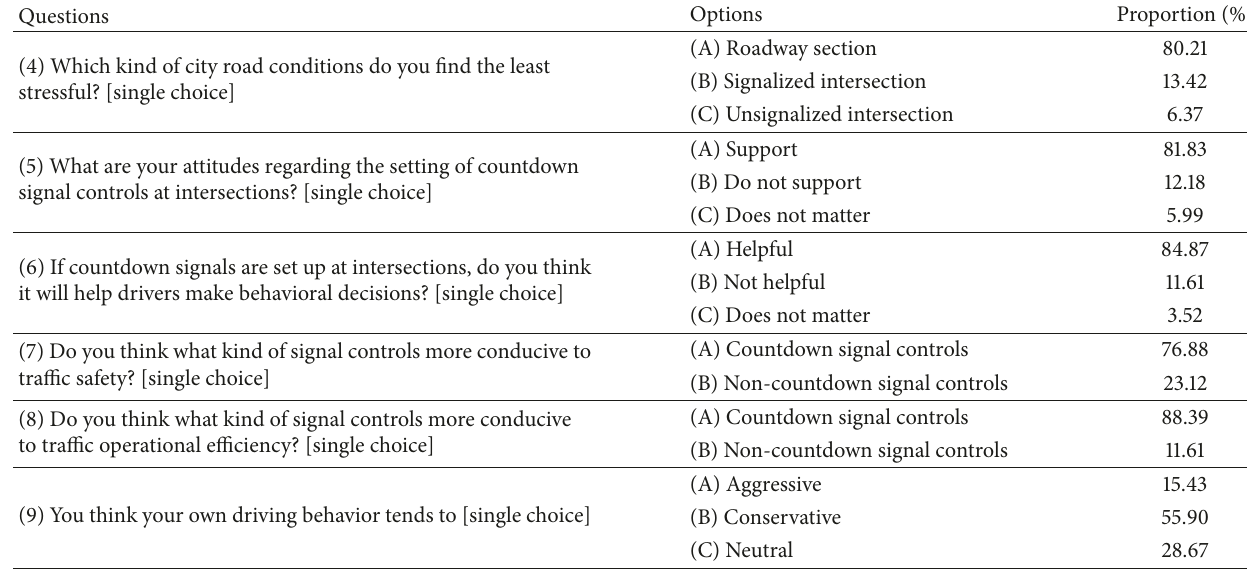
Table 2: Attitudes and understanding of surveyed drivers on countdown signal controls.